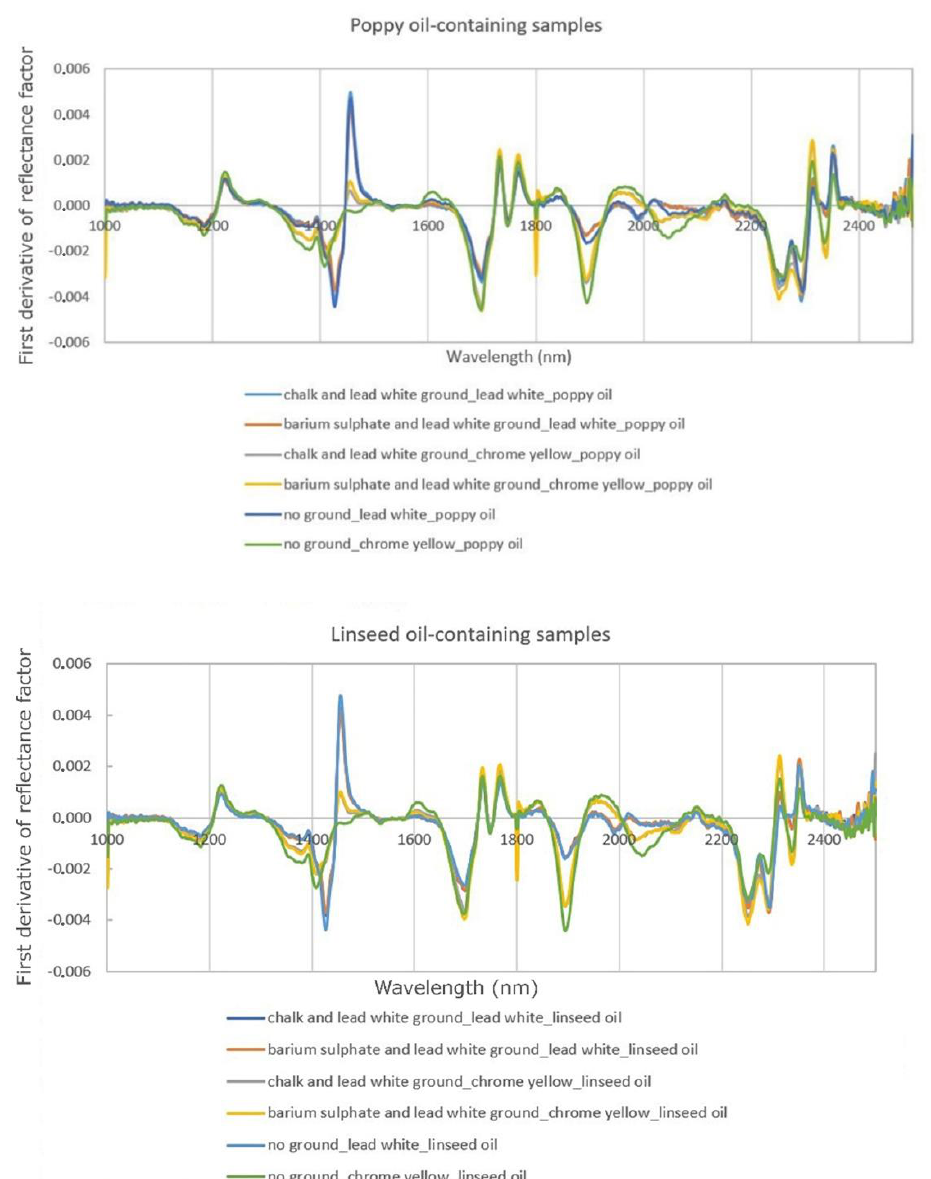
Figure 3. First derivative of the FORS spectra acquired from the experimental samples.